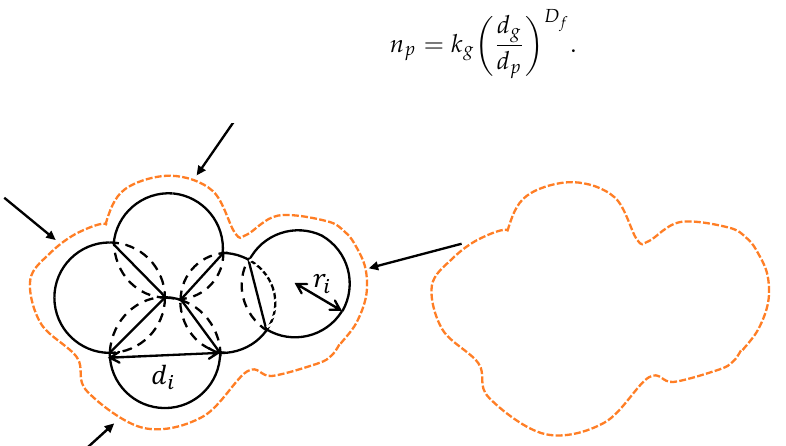
Figure 2. the aggregates composed of monomers and the circle of the cluster. Figure 2. The aggregates composed of monomers and the circle of the